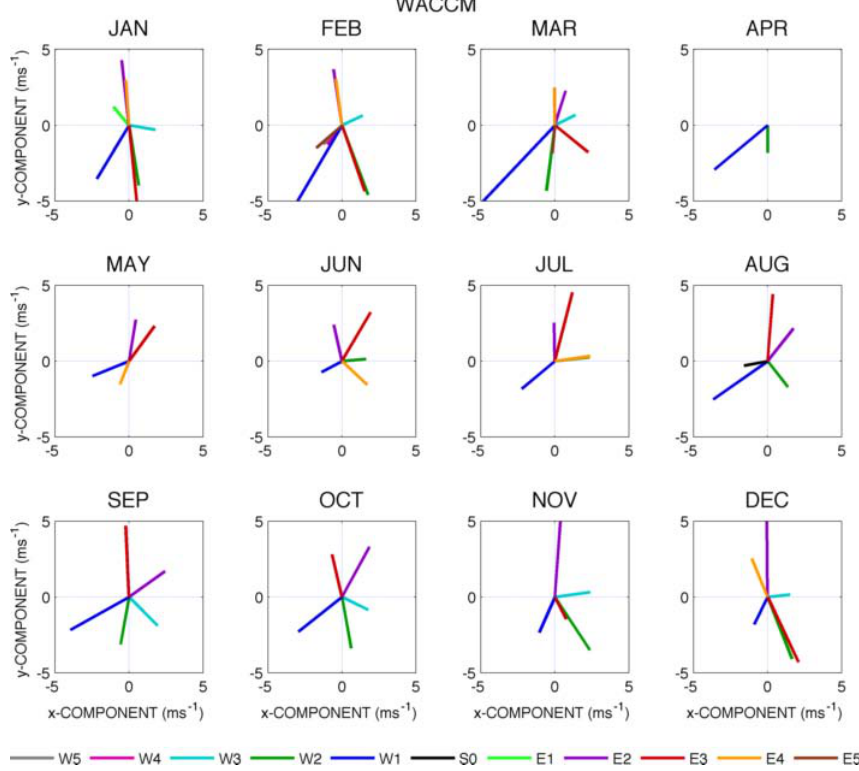
Fig. 19. Phasor plots of the individual wavenumbers contributing to the eCMAM-predicted zonal diurnal tide at a height of 90km. The length of each component represents the magnitude of its contribution, and the angle as measured anticlockwise from the positive x axis gives the phase. Only those components with magnitude greater than 1.5ms − 1 are